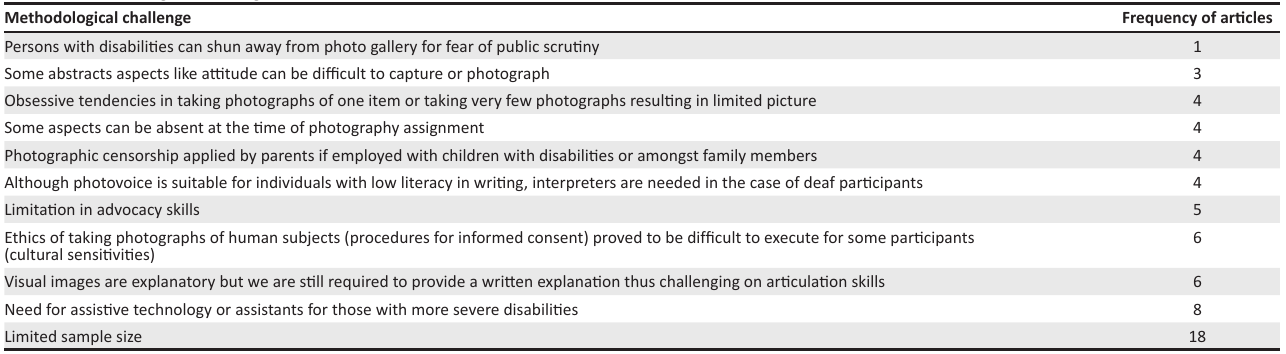
TABLE 3: Methodological